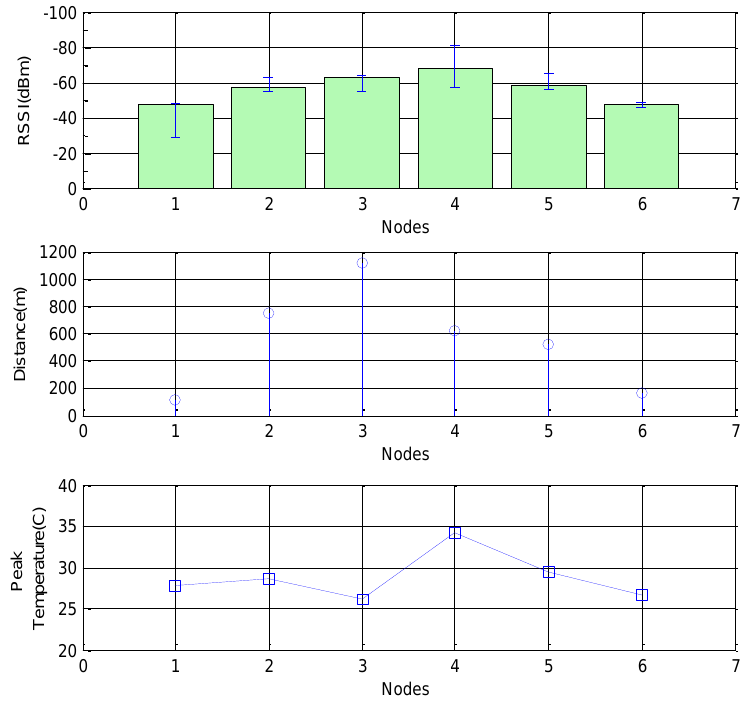
Figure 3. The correlation among distance, temperature, and